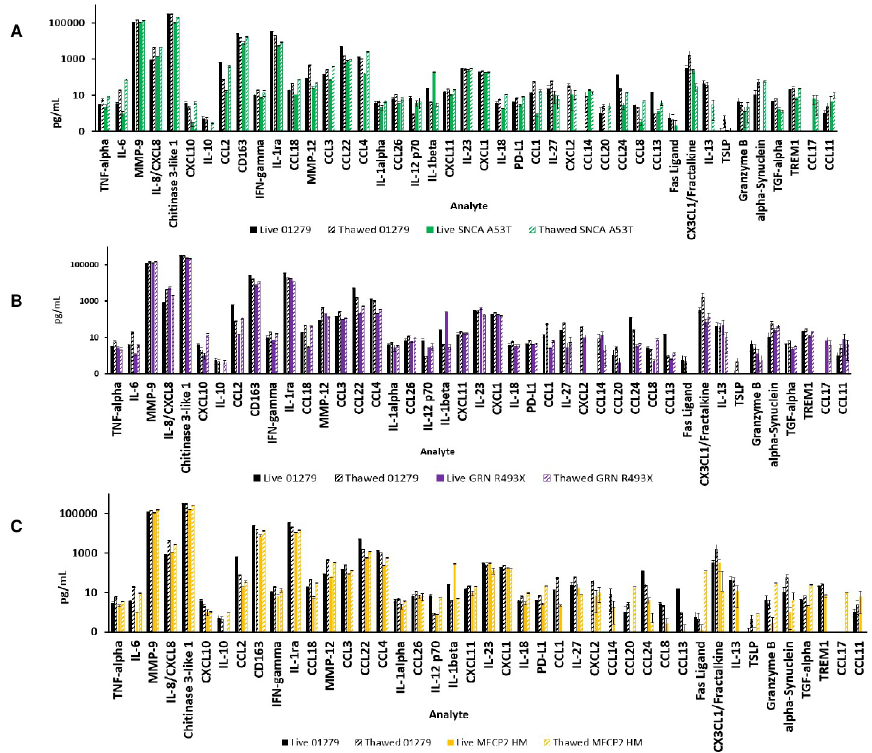
Fig 6. Polarization studies with iPSC derived macrophages from isogenic iPSC for disease modelling. Live end stage culture of macrophages as well as cryopreserved macrophages post thaw were allowed to recover for 72 hours in macrophage medium and placed in cytokine free medium overnight prior to addition of stimulants. Macrophages were stimulated with LPS, LPS + Interferon Gamma, IL-4 + IL-13, IL-10 + TGF-Beta, and TGF-Beta for 24 hours. Supernatants were collected, and release of cytokines was quantified by the Luminex multiplex system. The graphs depict the quantification of analytes released by unstimulated parental and engineered iPSC derived macrophages. Each value depicts the average of three samples ± SE. SNCA A53T (6a), GRN R493X (6b), and MECP2 HM (6c).